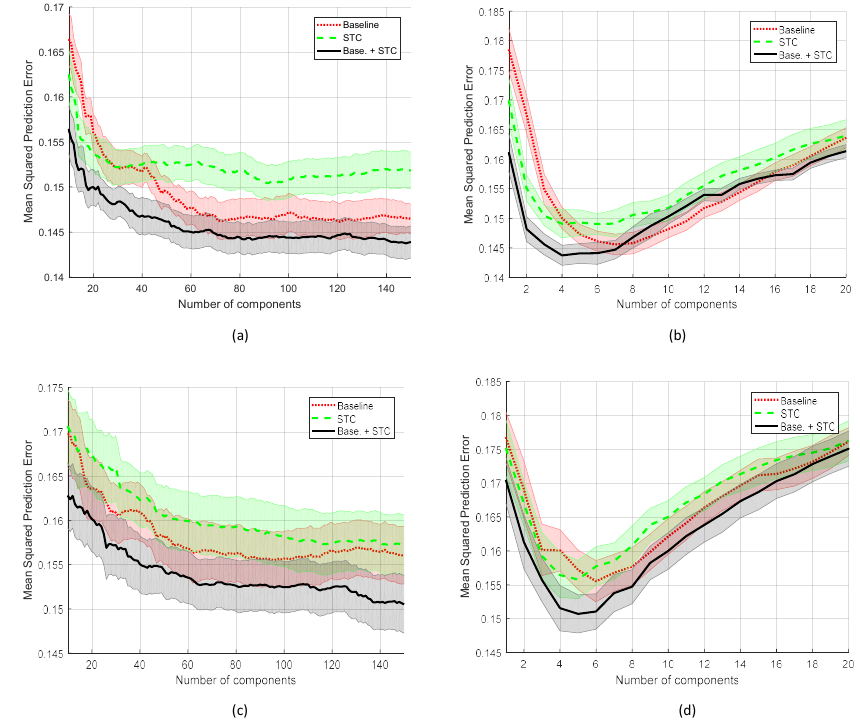
Figure 3. Root mean square errors (RMSEs) for the arousal dimension using ( a ) principal component regression models and ( b ) partial least square models. RMSEs for the valence dimension using ( c ) principal component regression models and ( d ) partial least square